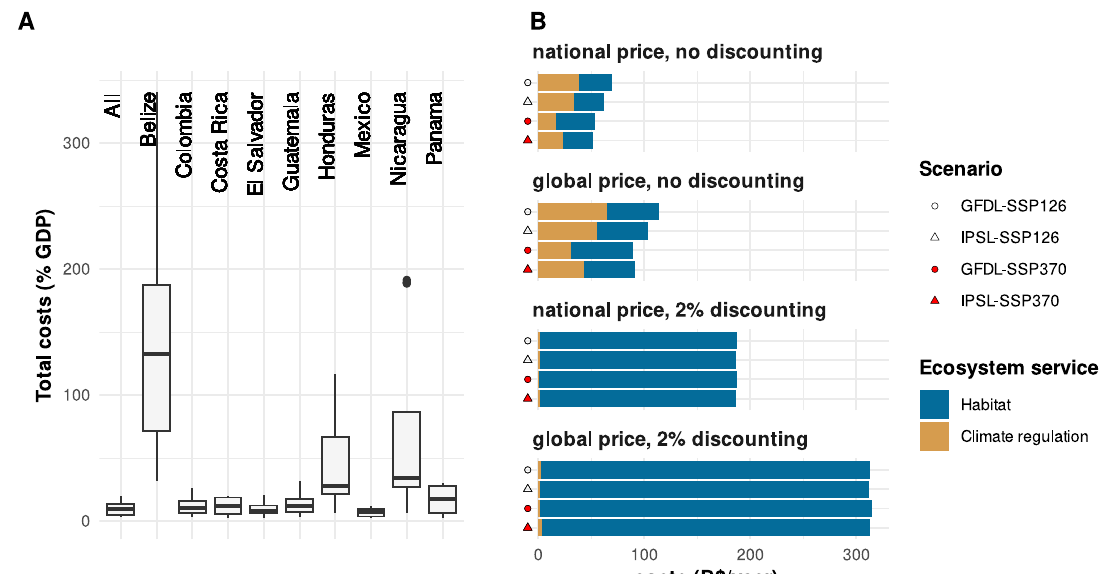
Fig. 2 | Economic costs of projected ecosystem service declines. A Boxplots of total costs by country as fraction of their GDP (computed across all price, dis- countingandclimatechangescenarios). B Costsforecosystemservicedeclinesfor the whole study region (billion $/year) for all combinations of price, discounting